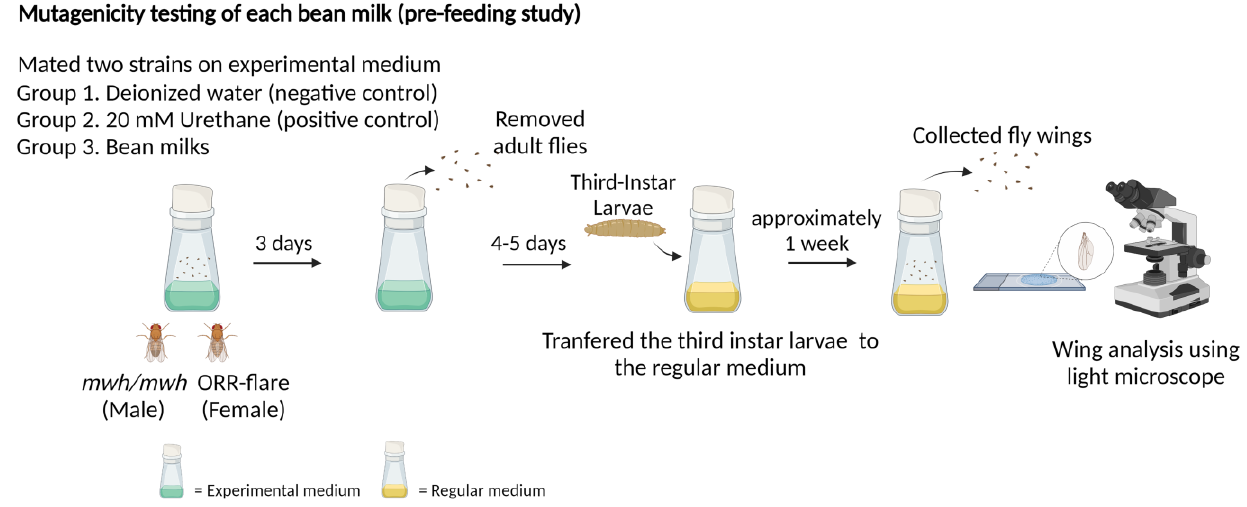
Figure 2. Experimental design of the pre-feeding study for mutagenicity testing: crossed adult flies were fed on the experimental medium containing each bean milk, water (negative control) or 20 mM urethane (positive control), and the third instar larvae were transferred to the regular medium. Wings were collected and analyzed for mutant spots.